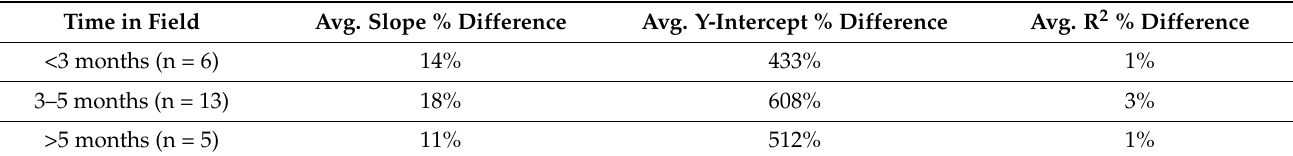
Table 1. Changes in calibration equations among AirUs deployed in Project ECHO.